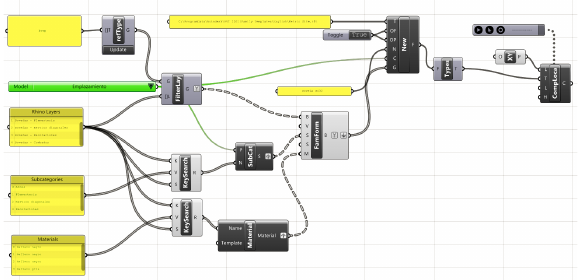
Figure 6. Grasshopper definitions for importing geometry from Rhinoceros into Revit.